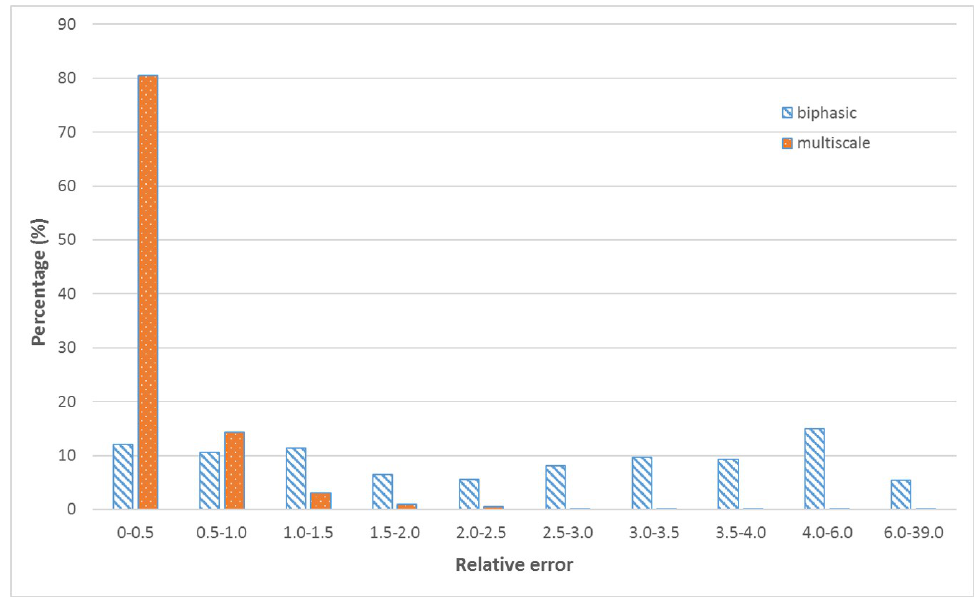
Figure 6. Distribution of relative errors obtained for predicting time-to-cure using machine learning with the biphasic and multiscale models. Measurements of reduced time points (0, 14 and 28 days) were used for the machine